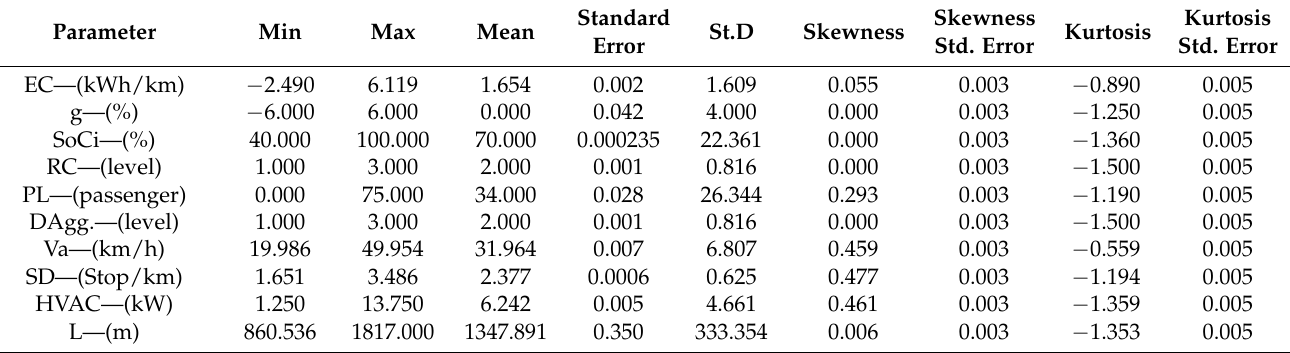
Table 5. Descriptive statistics of the dataset (n =